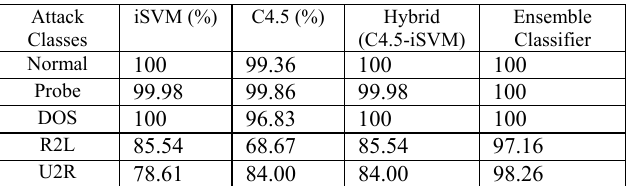
Table 8. Performance comparison of the ensemble